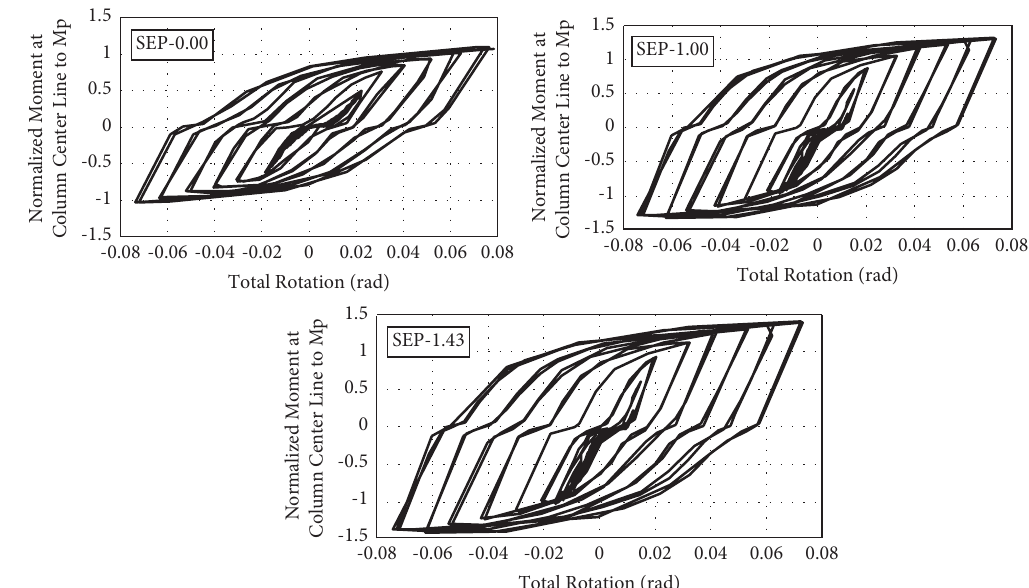
Figure 8: Hysteretic moment at the column centerline versus total rotation for all specimens.